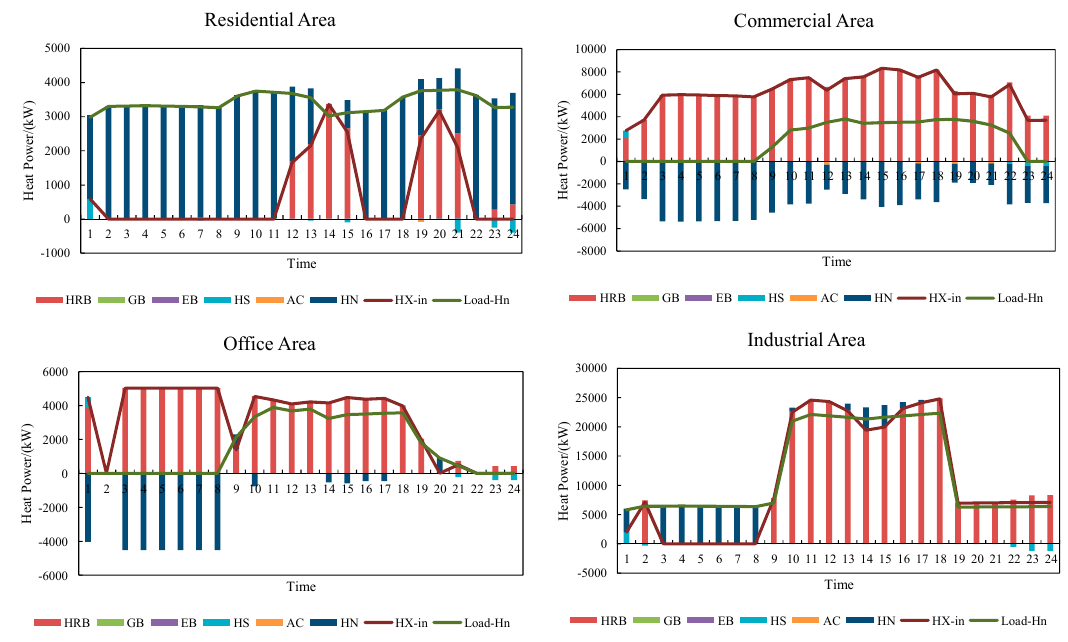
Figure 10. Dispatching results of heating power.